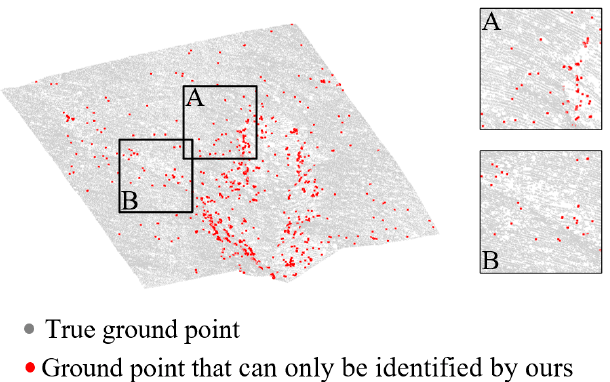
Figure 10. The ground points that can be identified only by the proposed method compared to the traditional k -nearest neighbor method. The proposed method obtains more accurate ground filtering results in the regions with uneven ground points, as shown in the enlarged figures A and B.